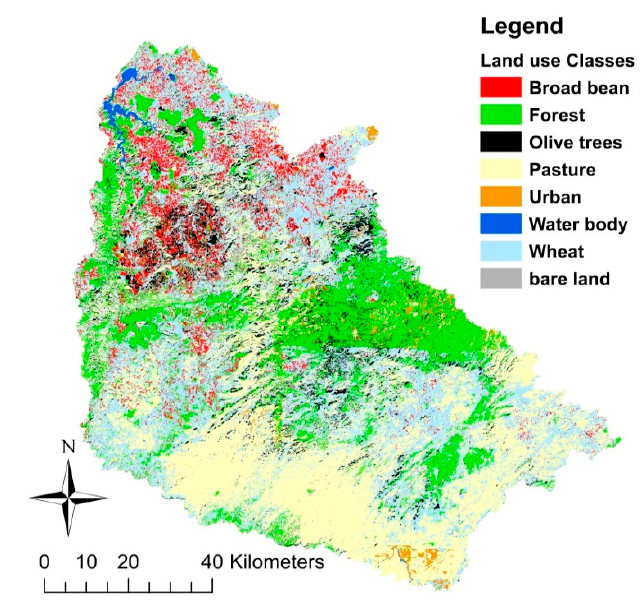
Figure 2. Land use classes in BW.